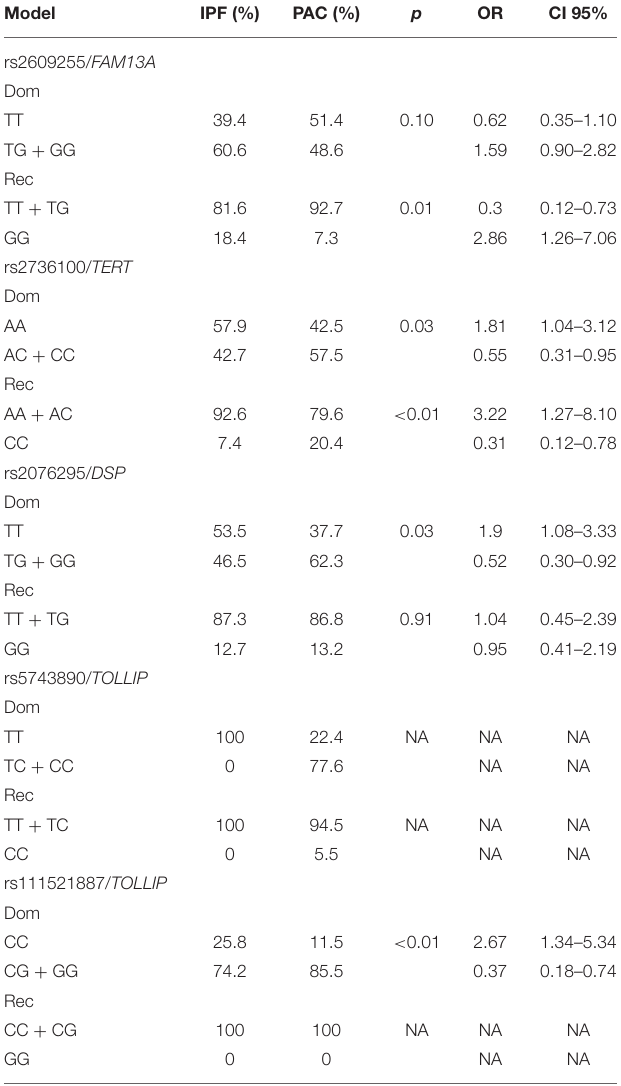
TABLE 6 | Dominant and recessive model of IFP vs. PAC comparison.